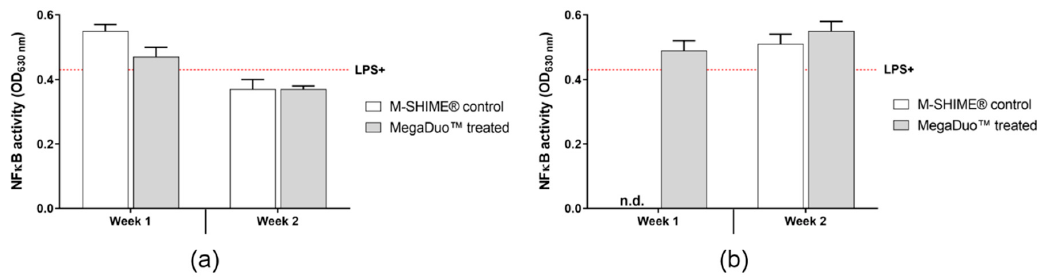
Figure 6. Effect of M-SHIME ® suspensions on NF κ B activity of PMA-treated THP1 cells after LPS stimulation in the Caco-2 / THP1-Blue ™ co-culture model ( a ) with or ( b ) without pre-treatment with clindamycin. Red dashed line = LPS (no M-SHIME ® supernatants). Error bars represent standard error of the mean. LPS = lipopolysaccharide; M-SHIME ® = mucosal simulator of the human intestinal microbial ecosystem.